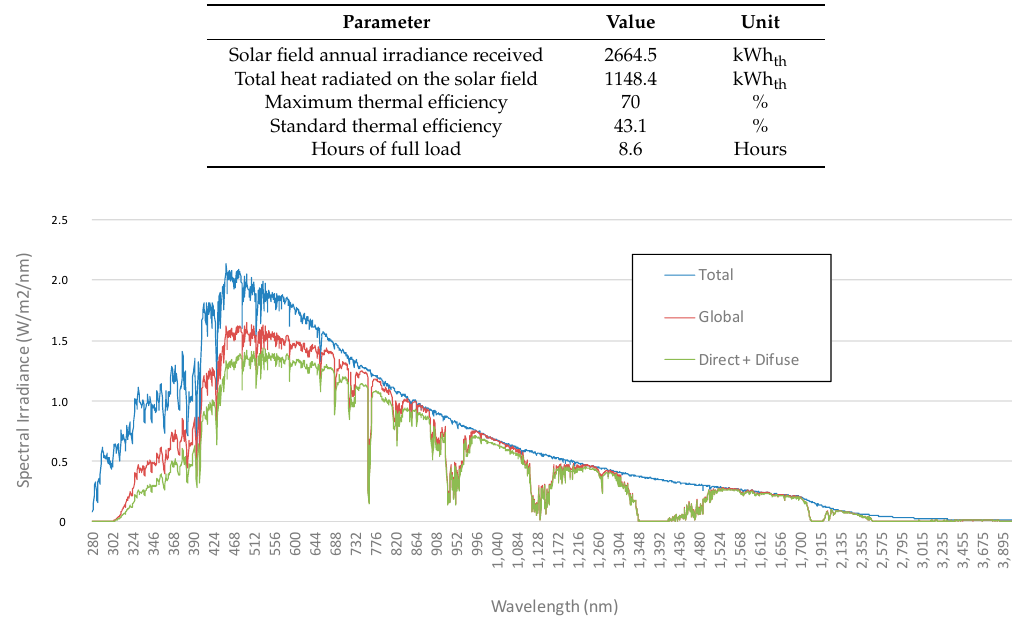
Figure 3. Solar spectral irradiance.